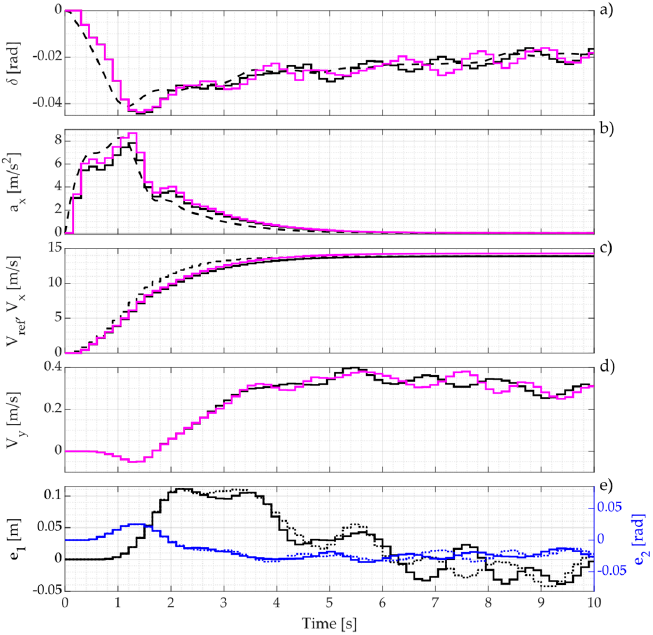
Figure 16. Results obtained during the right turn maneuver in PIL configuration (see Figure 10). Measured vehicle states for Speedgoat (black) and for Raspberry Pi 4B (magenta): ( a ) Front wheels steering angle δ ; ( b ) Longitudinal acceleration a x ; ( c ) Longitudinal speed reference V ref (black, dashed) vs. Actual longitudinal speed V x ; ( d ) Lateral speed V y ; ( e ) Cross track e 1 for Speedgoat (black, solid) and Raspberry Pi 4B (black, dotted) and Relative yaw angle e 2 for Speedgoat (blue,